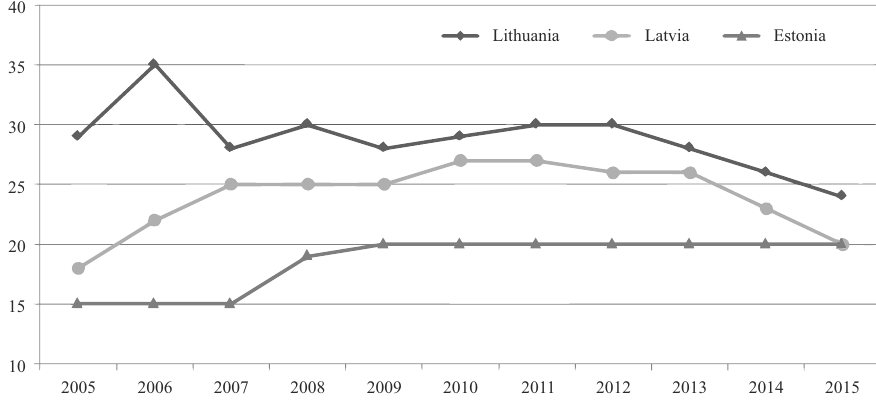
Fig. 2. Number of second pillar pension funds in Lithuania, Latvia and Estonia from inception until